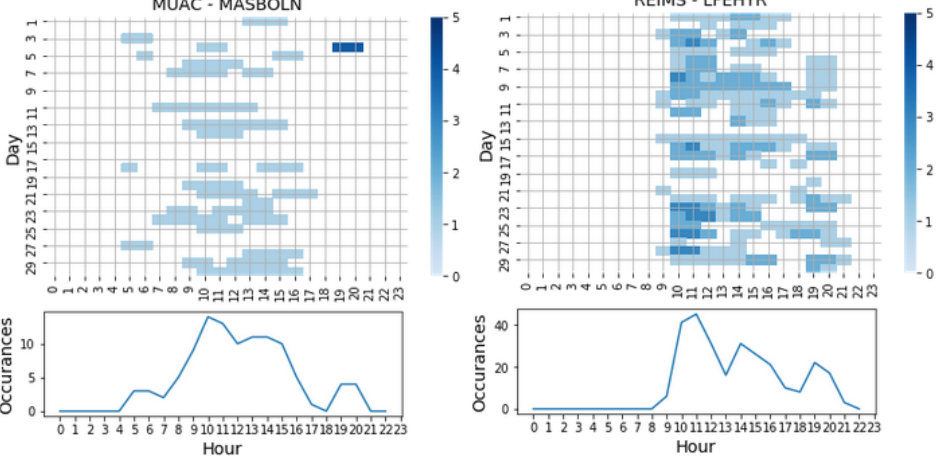
Figure 12. All implemented regulations in the TV MASBOLN-MUAC region ( Left ) and in the tv LFEHYR-REIMS region ( Right ). The darker the color, the more regulations were implemented on the same day and hour across the four